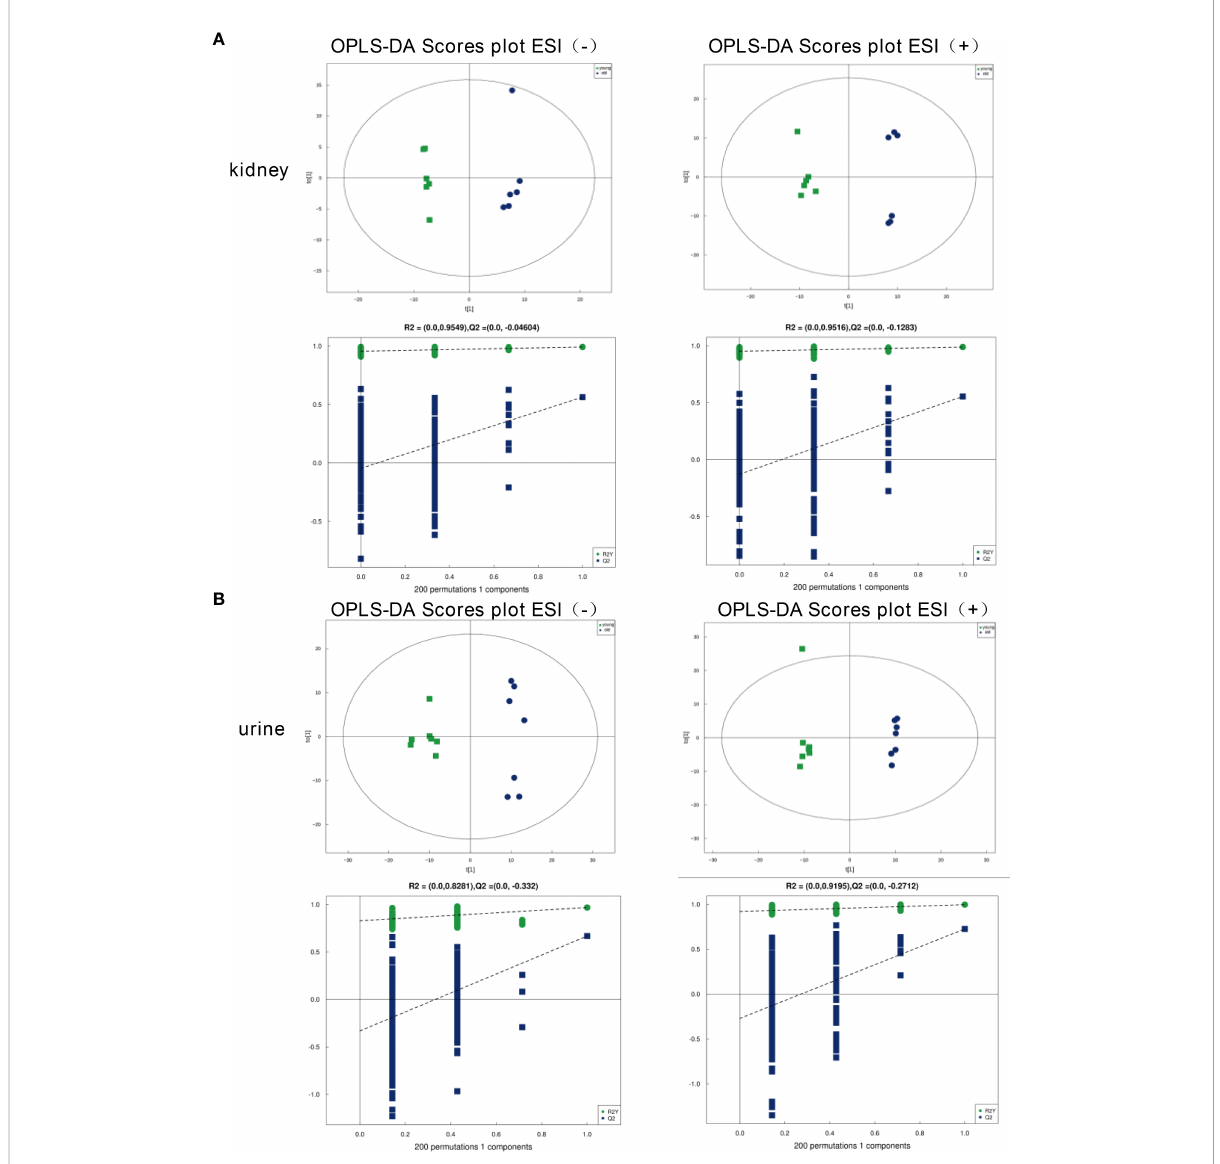
FIGURE 2 OPLS ‐ DA score plots of the kidney and urine metabolic pro fi les. (A) Kidney samples under the ESI ( − ) or ESI (+) modes. (B) Urine samples under the ESI ( − ) or ESI (+)